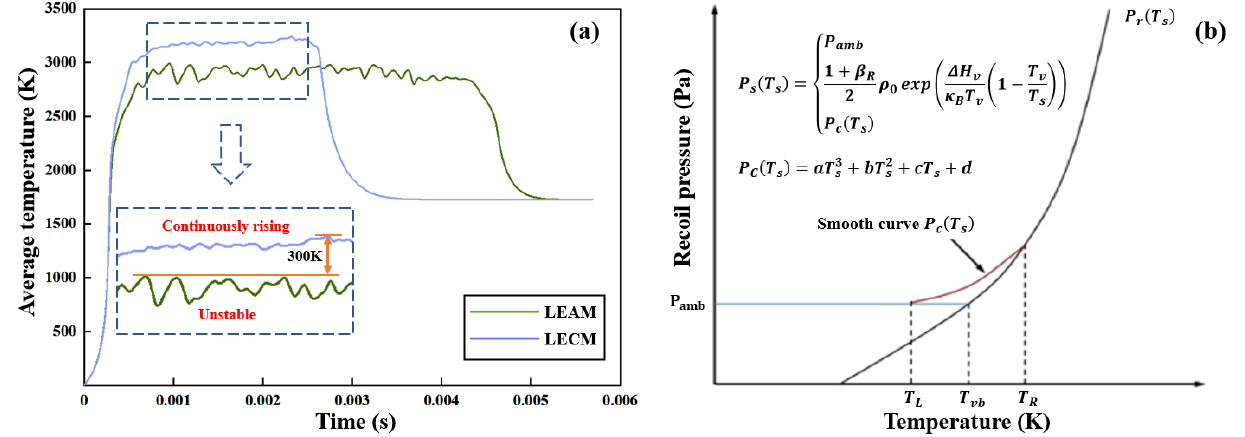
Figure 9. ( a ) Comparison of the average temperature inside the keyhole of LEAM and LECM. ( b ) Diagram of the recoil pressure dependence with temperature.